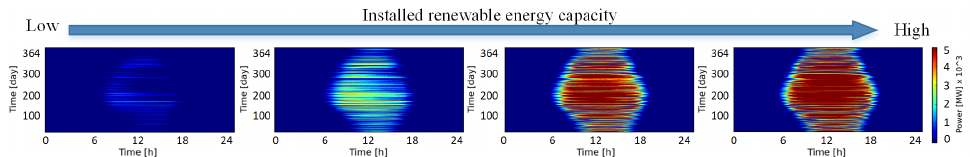
Figure 10. Positive imbalance magnitude and frequency increase with installed renewable energy capacity as overgeneration does not cover unfulfilled demand. Shifting energy in time to meet temporal mismatch between renewable output and demand increases utilization potential.